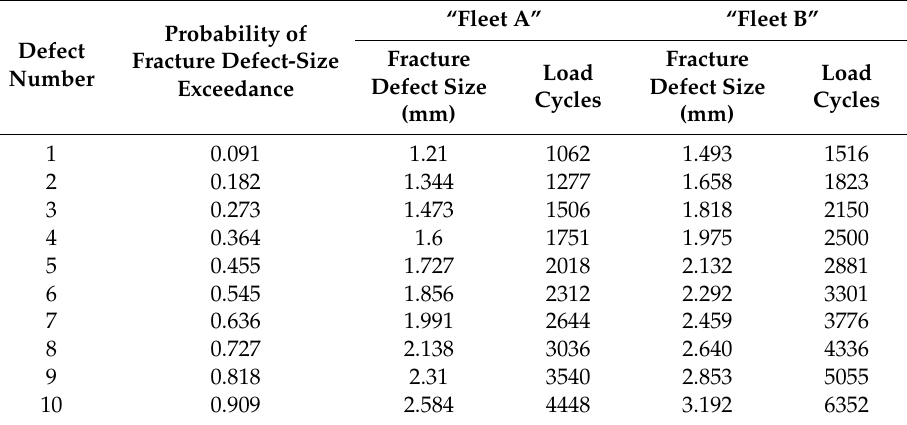
Table 6. 10 defect size after a component fracture.